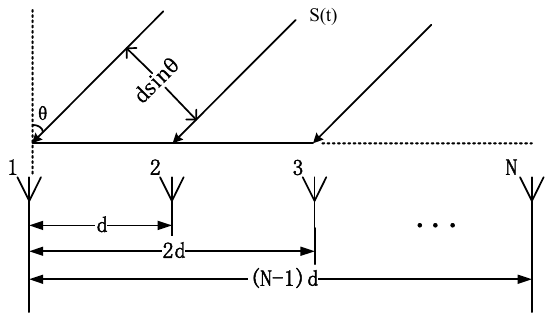
Figure 1. Diagram of a N-elements ULA.